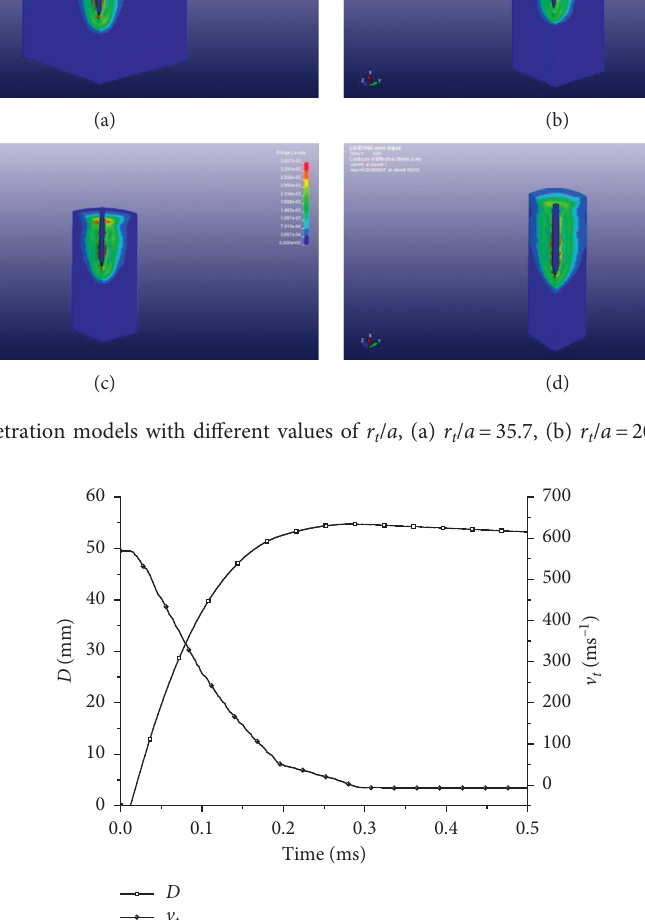
Figure 13: Time-history curves of the penetration depth and penetration velocity for the